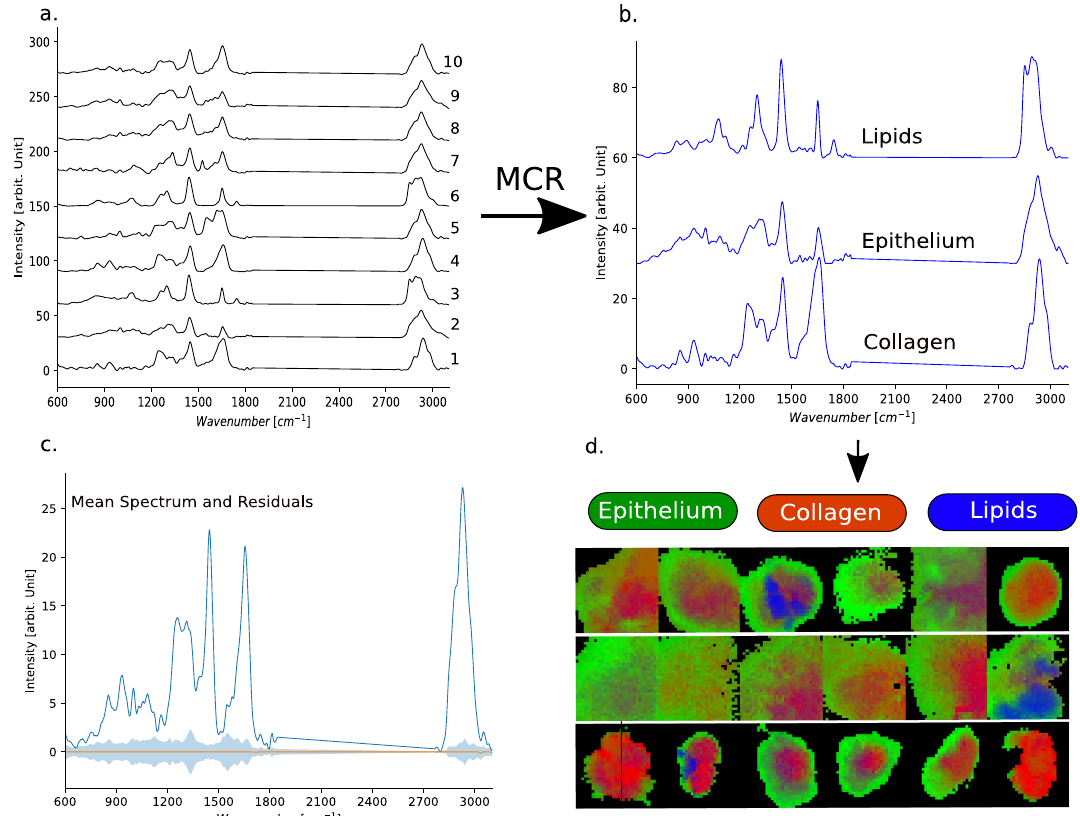
Figure 8. To determine ‘pure’ component spectra, which best represent the three major tissue components, i.e. epithelium tissue, collage, and esterified lipids, a combination of VCA and MCR-ALS was used. Ten endmember spectra extracted from the dataset, using vertex component analysis are displayed, ( a ) Three components from the VCA-endmembers were selected as the initial guess for MCR, i.e. Nr. 1 (collagen), Nr. 3 (esterified lipids), and Nr. 8 (epithelium tissue) and the resulting pure component spectra are shown, ( b ) The mean spectrum of the data set and the standard deviation of the residuals is plotted, ( c ) To better visualize the results the maps on the distribution of the three components are presented as RGB-maps for the several biopsies, ( d